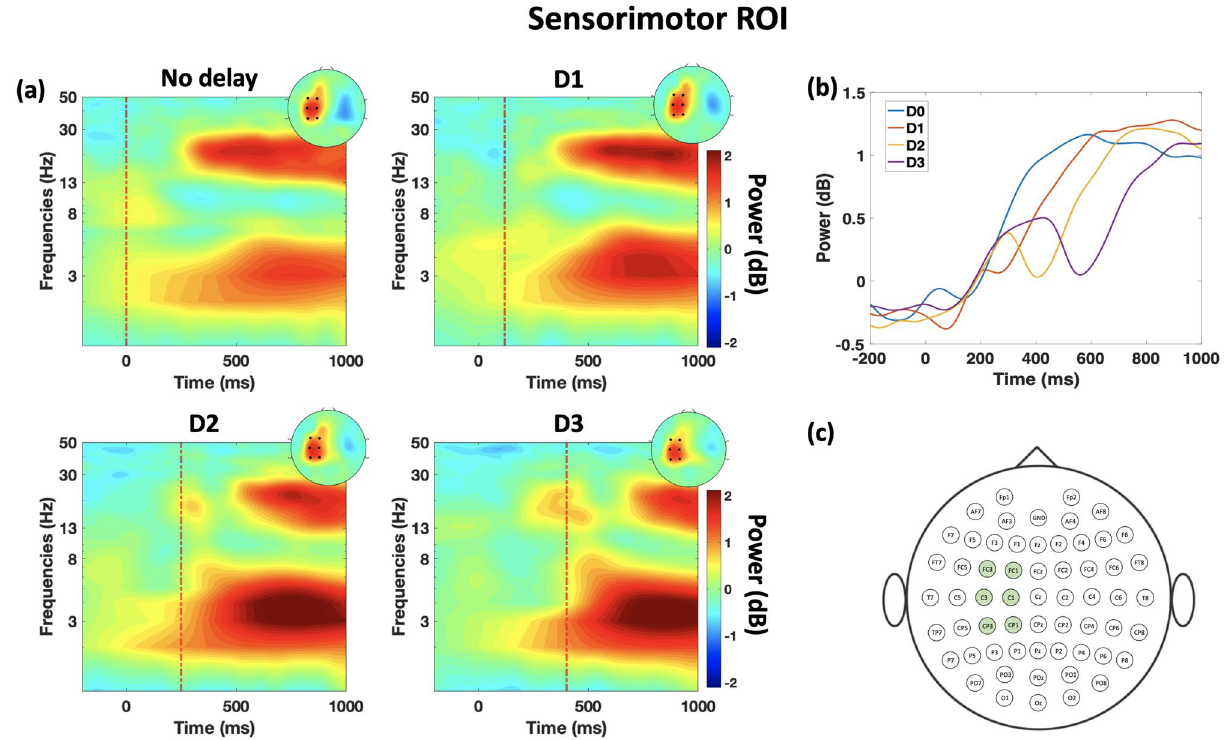
Figure 6. Time–frequency representation of the sensory correlates at the sensorimotor ROI. ( a ) ERSP dynamics of the EEG data in the sensorimotor ROI averaged over trials and subjects per condition. The dashed red line shows the event of the haptic feedback disable. Topography plots are obtained by averaging power in the window of 400+ delay –600+ delay ms where the maximal effect of beta rebound is observed. ( b ) Time-course of the beta power under the four delay conditions. The compounded beta rebound can be observed particularly clear at D2 and D3. ( c ) Channels included in the sensory correlates analysis at the sensorimotor